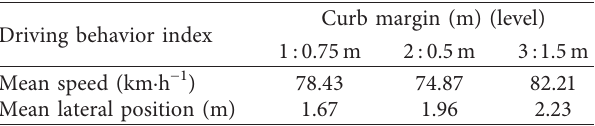
Table 2: Driving behavior index results of various levels of plant distance factors.